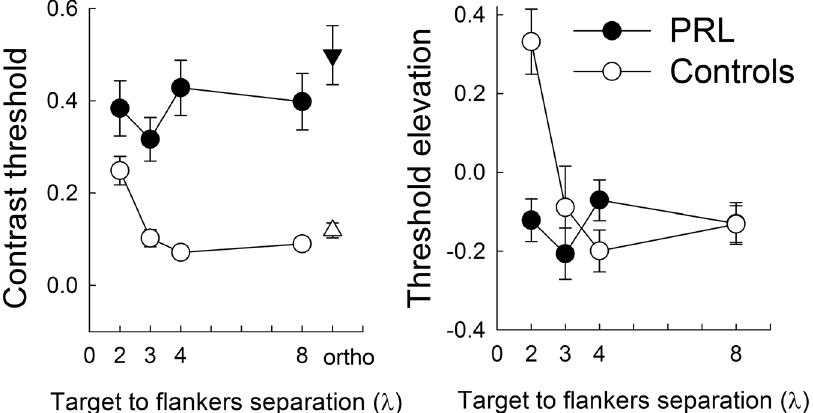
Figure 3. Contrast threshold and TE values (i.e., lateral interaction curves) as a function of target-to-flanker distance for MD patients (PRL data) and controls (data averaged across retinal positions). Contrast thresholds for the orthogonal configuration (8 λ ) are also shown. Bars indicate standard